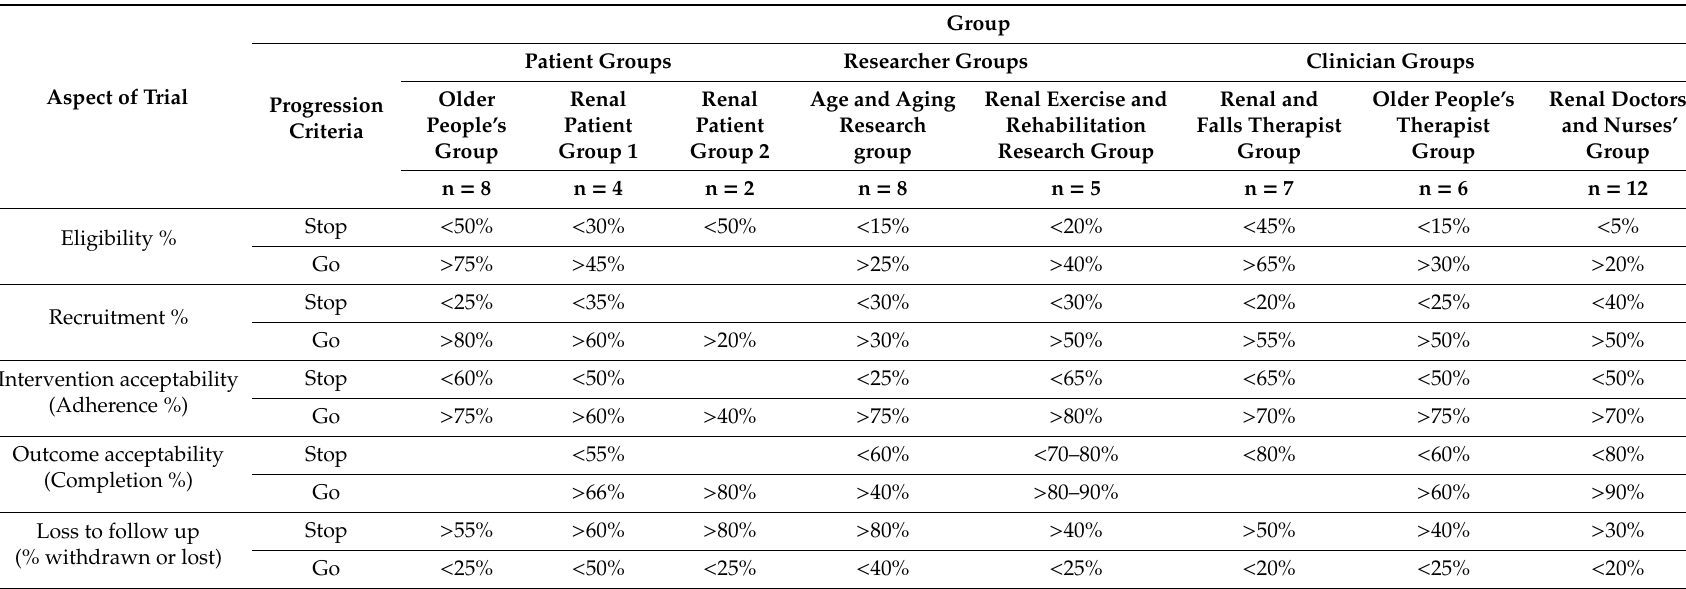
Table 4. “Stop” and “Go” progression criteria decided by individual discussion groups. Progression criteria are expressed as a percentage; blank fields indicate that the group did not set progression criteria for that aspect of the